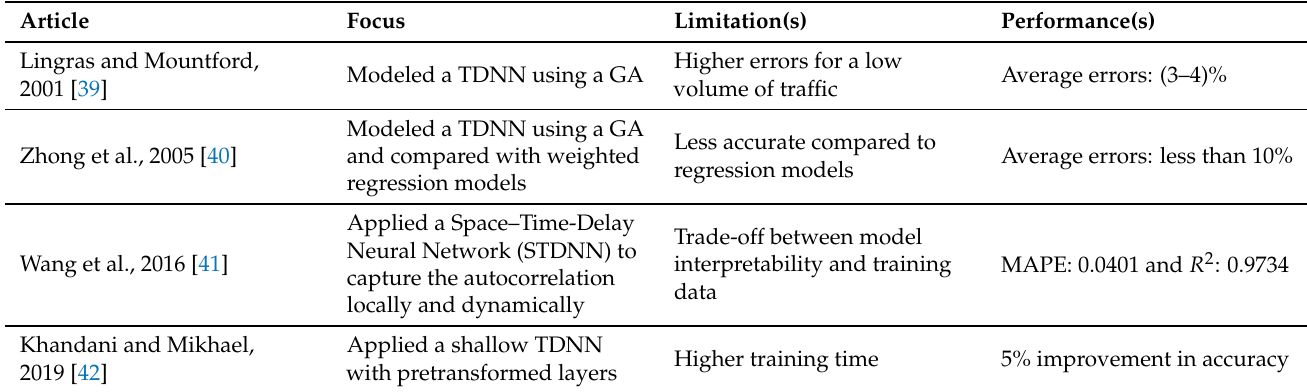
Table 4. Summary of the works found using TDNNs.